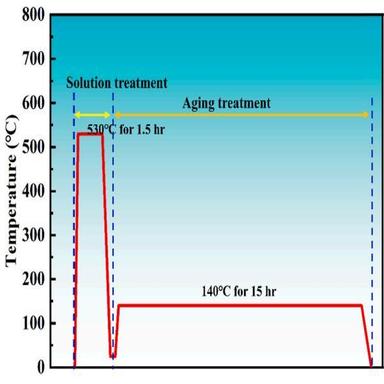
The optimal T6 heat treatment for 2024-5 vol% TiCN composite.